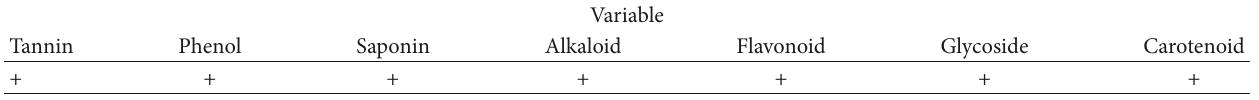
Table 1: Qualitative phytochemical analysis of SAP.